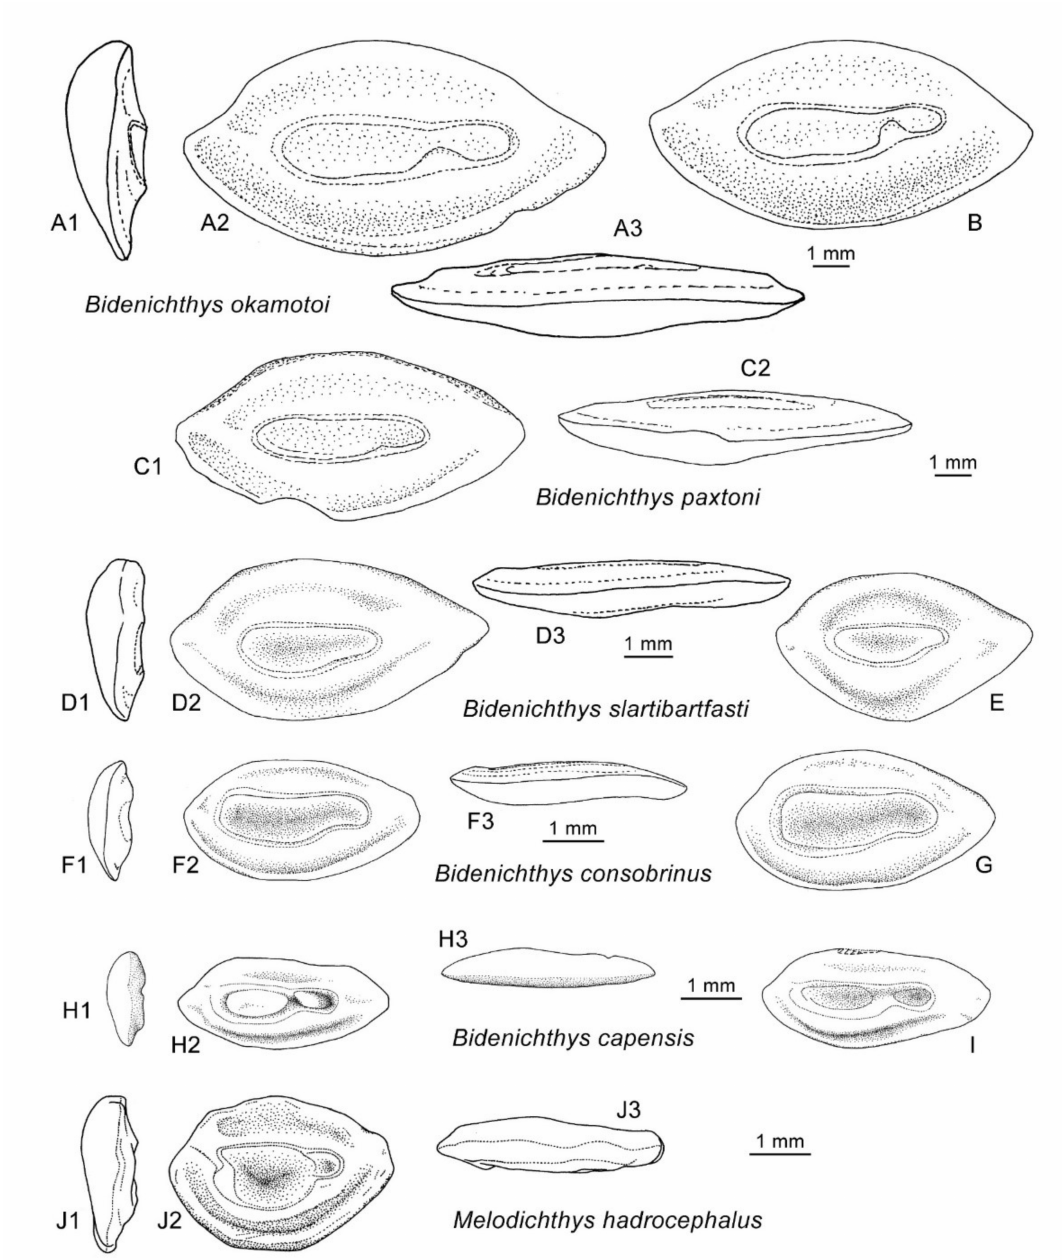
Figure 3. Otoliths inner faces and selected anterior and ventral views (H3 + J3 = dorsal views); A , B , Bidenichthys okamotoi n. sp. ( A , holotype, ZMUC P2397717, B , paratype, ZMUC P2397390); C , Bidenichthys paxtoni [5], NMNZ 18430; D , E , Bidenichthys slartibartfasti [6], NMNZ 35097; F , G , Bidenichthys consobrinus [3], ZMUC P77800-03; H , I , Bidenichthys capensis [1], ZMUC P77470; J , Melodichthys hadrocephalus [5], MNHN